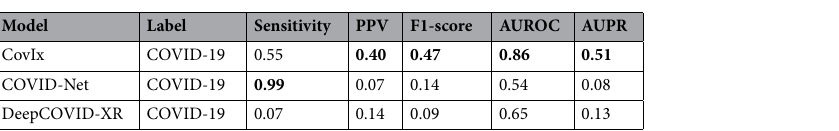
Table 2. Model performance comparison in identifying COVID-19 CXRs. Top results are shown in bold.